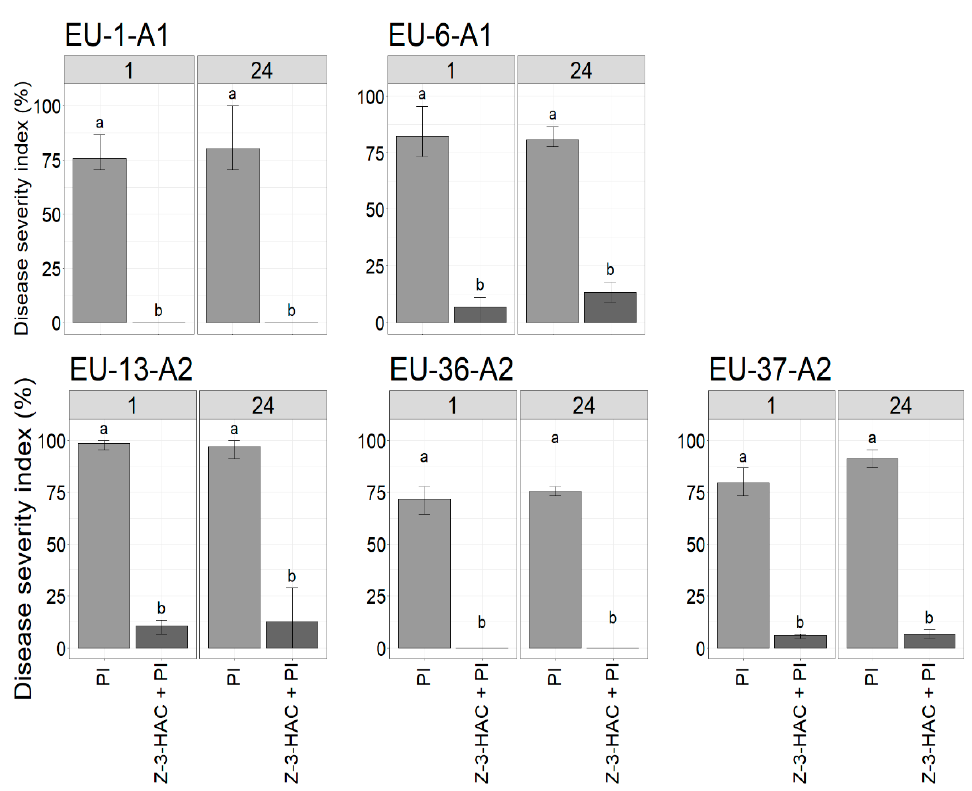
Figure 5. Barplots showing the variation in the late blight disease severity index (%) between unexposed potato leaves inoculated with various P. infestans genotypes (EU-1-A1, EU-6-A1, EU-13- A2, EU-36-A2, EU-37-A2) (PI) and leaves pre-exposed to the Z-3-HAC and subsequent infection with P. infestans genotypes (Z-3-HAC + PI) at 1 and 24 h postexposure. Bars with different letters represent values that are significantly different according to Dunn’s test ( p -value > 0.05). All measurements were assessed seven days after infection.